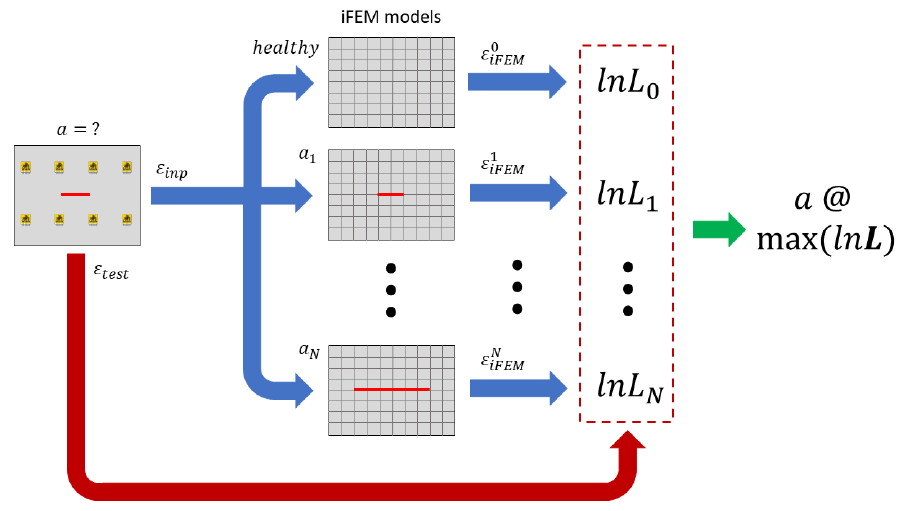
Figure 5. Crack size estimation